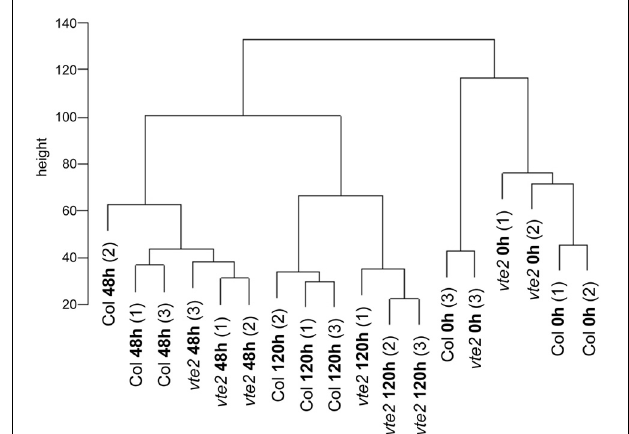
FIGURE 1 | A cluster dendrogram of a correlation matrix for all-against-all chip comparisons. The scale on the vertical bar “height” indicates Manhattan distance. The numbers (1) to (3) indicate three independent biological replications for treatments and genotypes. The samples cluster by different genotypes (Col and vte2 ) after LT treatment (48 and 120